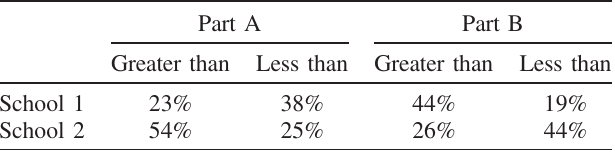
TABLE II. Pretest response comparison: “ greater than ” versus “ less than. ” Numbers shown indicate the percentage of incorrect responses at each of the two schools. This is necessary because significantly more students answered the PRQ correctly at school 1 than at school 2. Only by looking at the percentages of incorrect responses can meaningful comparisons be